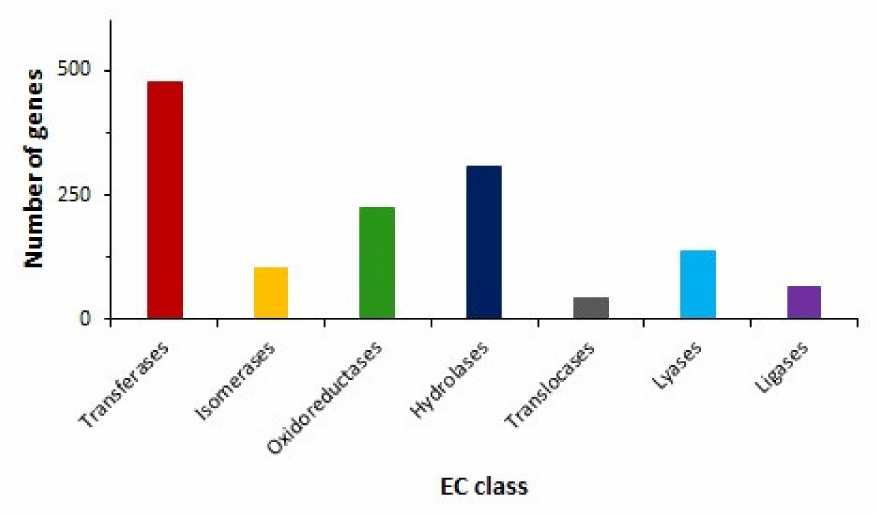
Figure 5. Distribution of genes encoding enzymes within enzyme class (EC) based on Kyoto Encyclopedia of Genes and Genomes (KEGG) pathways analysis. Colored bars indicate amounts of genes assigned to EC